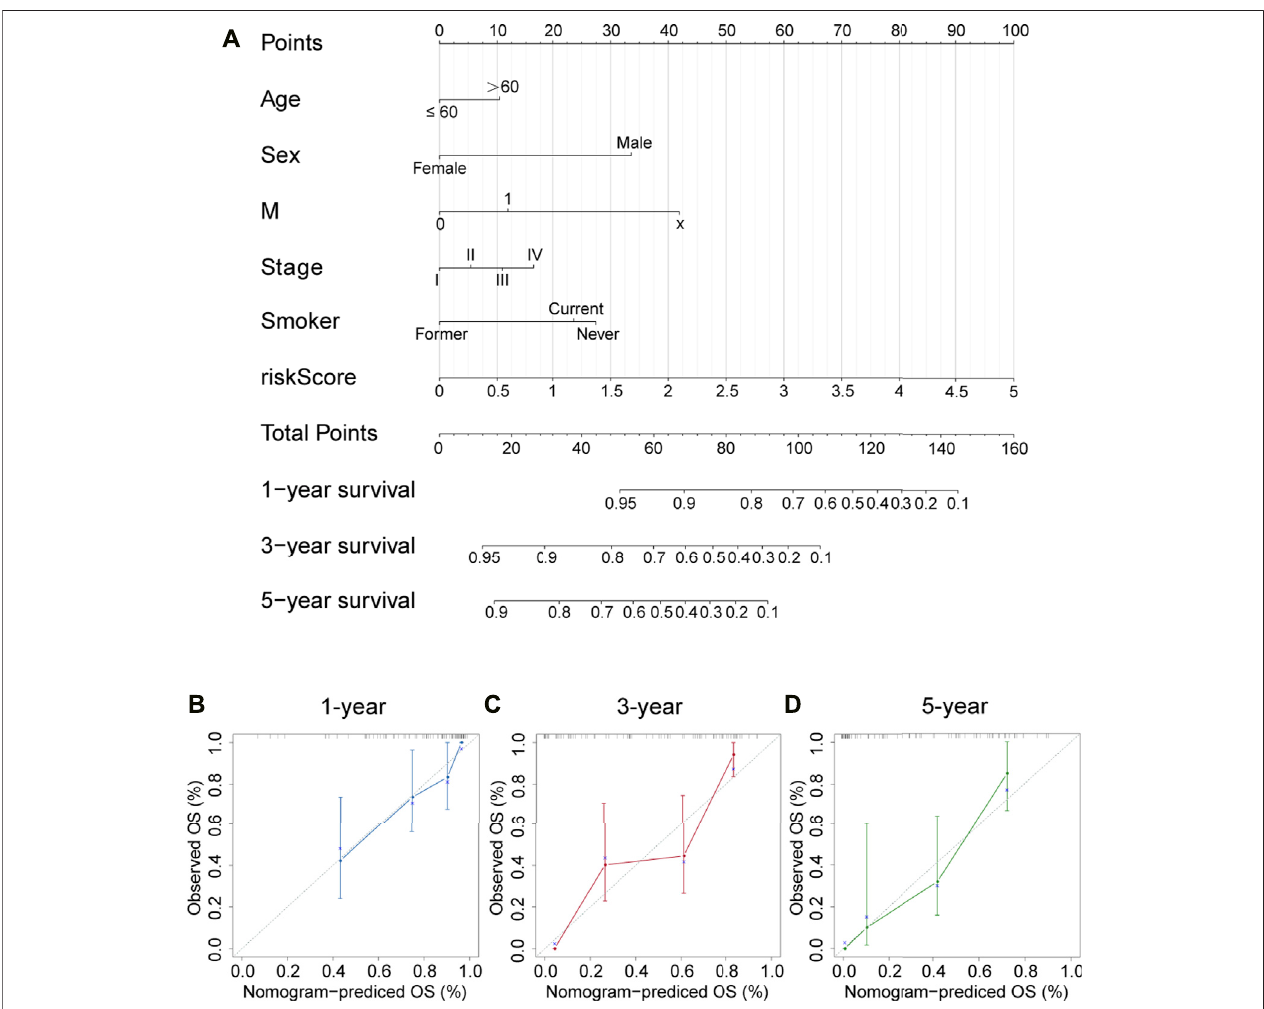
FIGURE7| Nomogramand corresponding calibration plots. (A) Anomogramthatintegratedtheriskscoreandotherclinicopathologicalfeatures forpredicting 1-, 3-,and5-yearOSofSCLC.Scoresofeachvariablearecalculatedbydrawingalineverticaltothetoppointsrow,andthenatotalscorecanbeobtainedbysummingup thesescores.Subsequently,averticallinecouldbeprojectedfromtotalpointstothebottomscalestoestimatethesurvivalprobabilityofpatients. (B – D) Calibrationplots for 1-, 3-, and 5-year nomogram in the cBioPortal cohort. Nomogram-predicted survival is depicted on the X -axis, and observed actual survival is plotted on the Y -axis. The 45-degree dotted line indicates a perfect